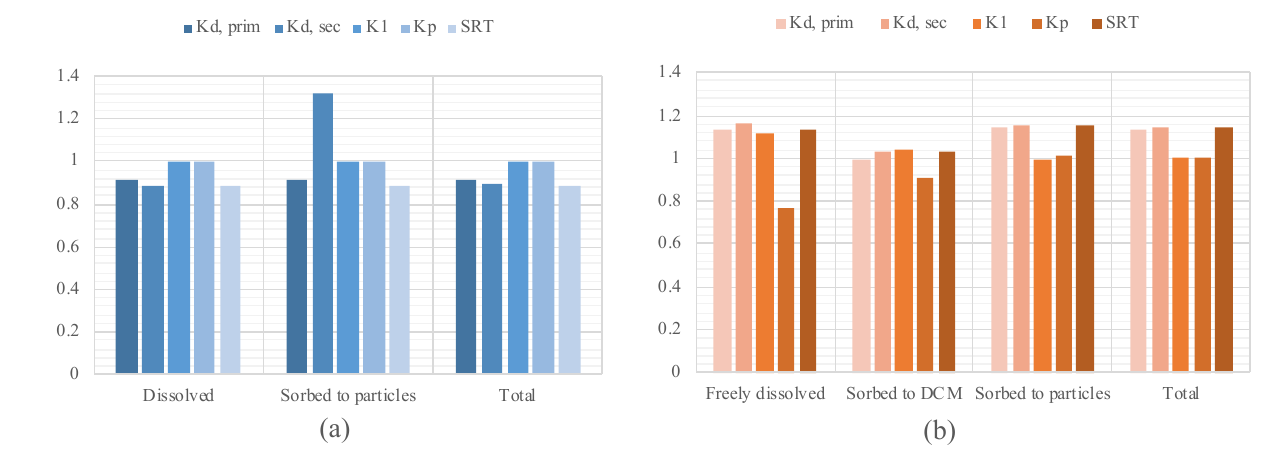
Figure 7. Sensitivity analysis for a 50% increase in K d,prim , K d,sec , k 1 , K p , and SRT. Response variables include naphthalene loads in WWTP ( a ) effluent and ( b ) biosolids.